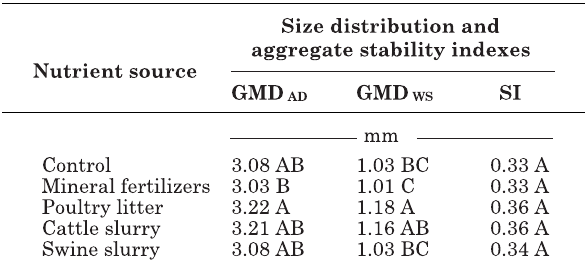
Table 8. Size distribution and aggregate stability